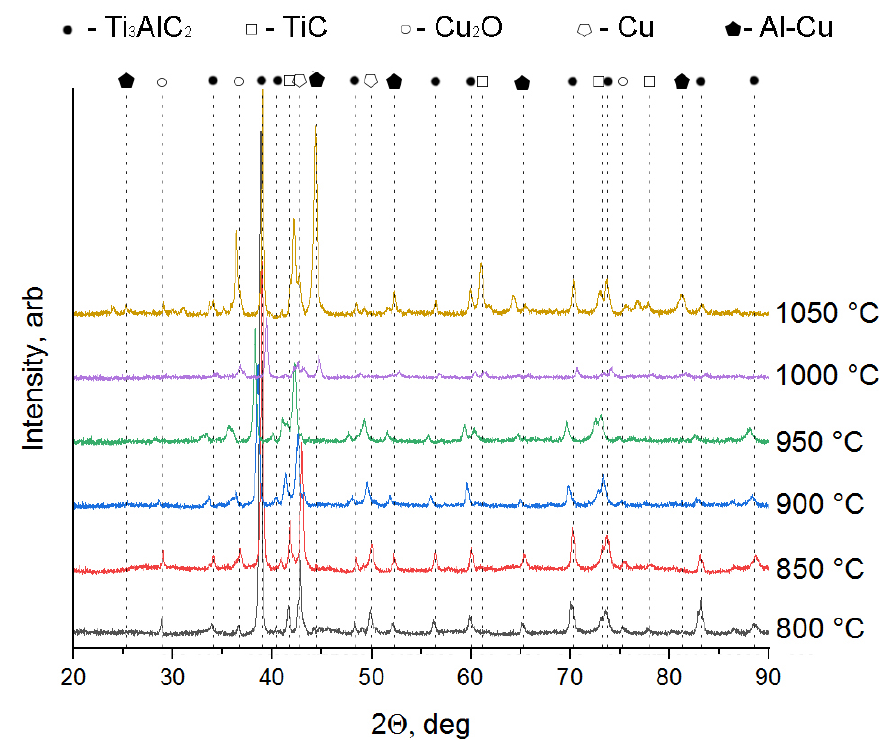
Figure 4. XRD patterns of Ti 3 AlC 2 : Cu (1:1) samples after sintering at different